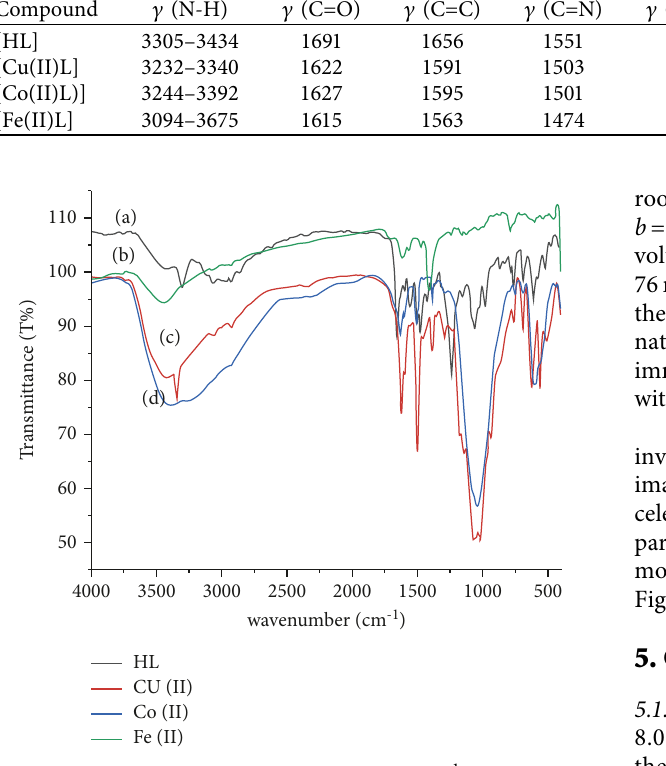
Figure 3: IR spectra at the range 400–4000cm − 1 for the (HL) ligand and its metal complexes. (a) HL. (b) Fe(II)L. (c) Cu(II)L. (d)